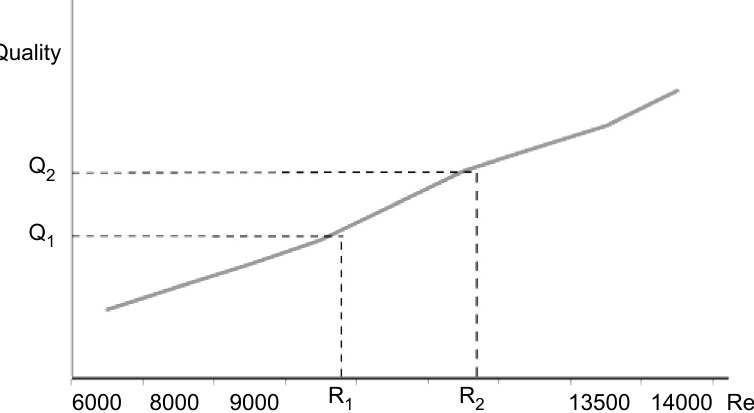
Figure 1. Rent-quality